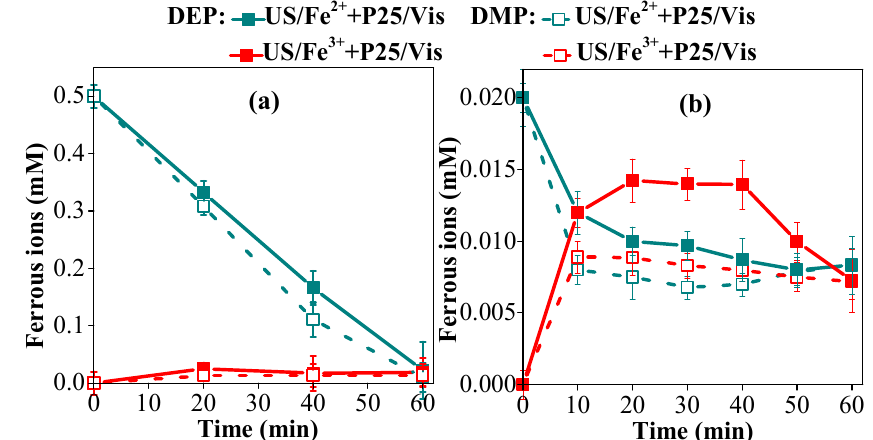
Figure 5. Variation of ferrous ion concentrations during the degradation of DMP or DEP in the combined processes of sono-Fenton and P25-mediated visible light photocatalysis at two different levels of iron species: ( a ) 0.5 mM, ( b ) 0.02 mM ([DMP]0 = 0.01 mM, [DEP]0 = 0.01 mM, P25 dosage 0.5 g L −1 ).